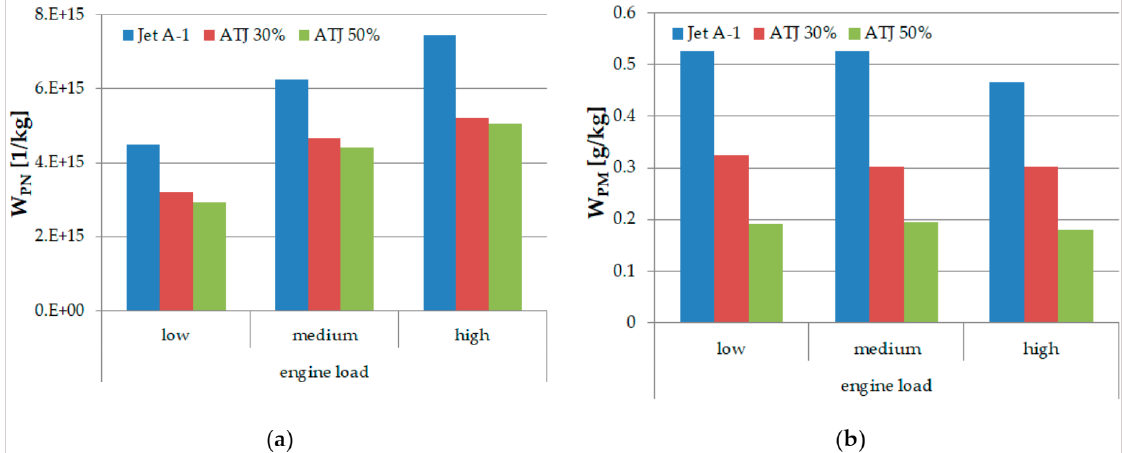
Figure 10. Particle number index W PN ( a ) and particle mass index W PM ( b ) for tested fuels in three engine load